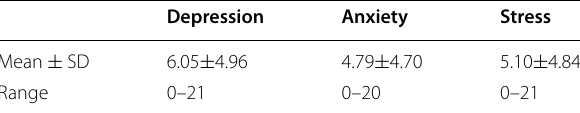
Table 3 Mean scores of depression, anxiety and stress among the healthcare professionals using DASS-21 ( N